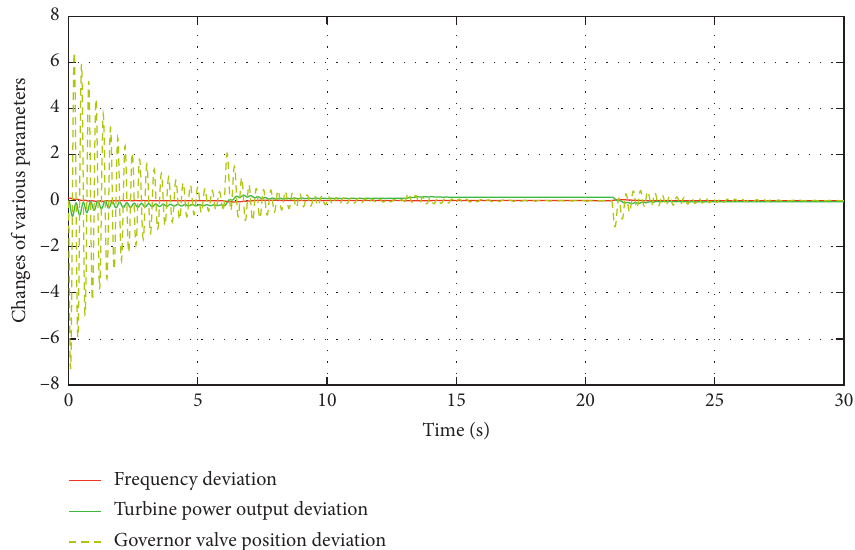
Figure 7: State deviation (frequency, power output, and governor valve position) of the